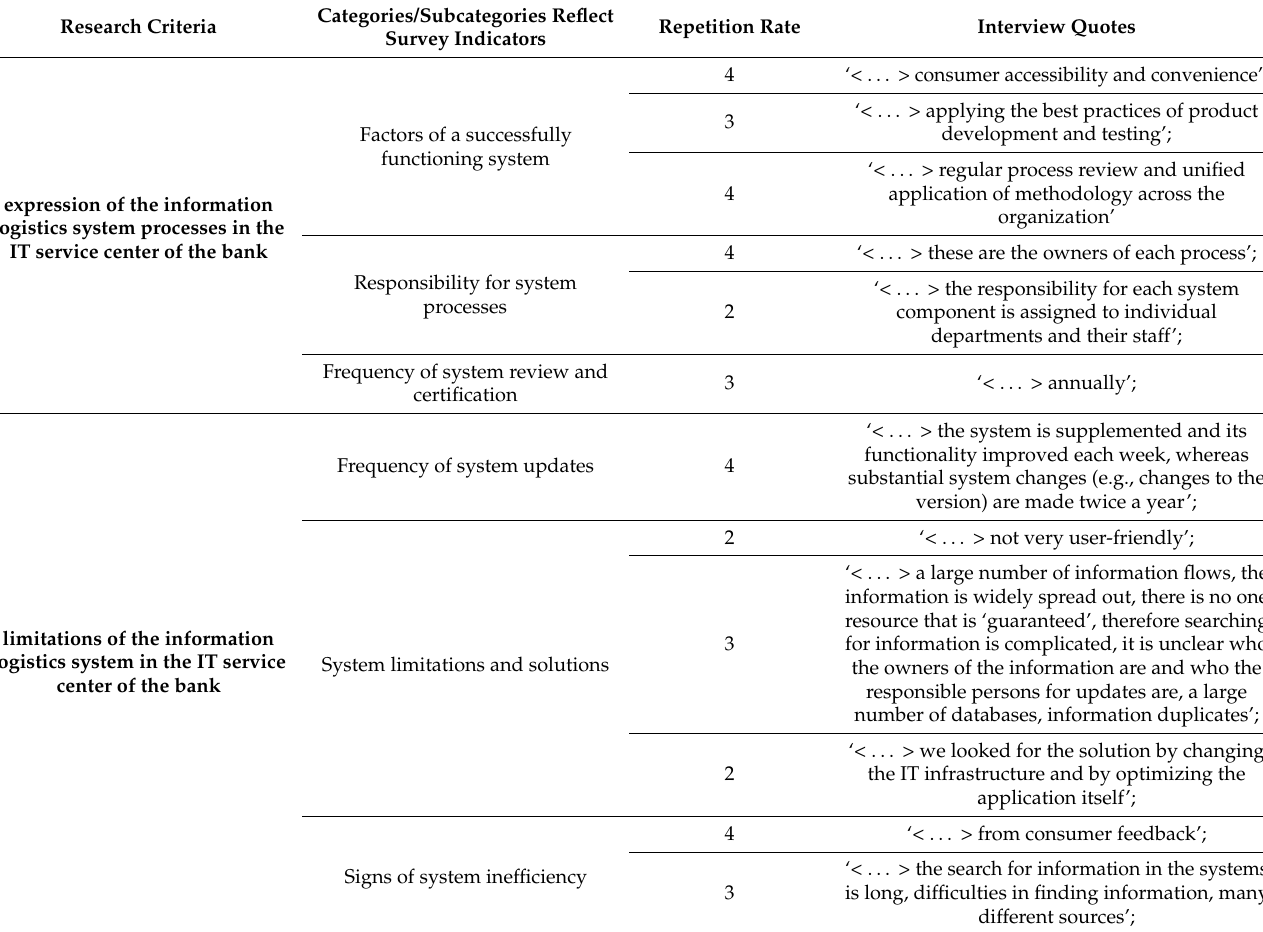
Table 1. Triangulation Findings of the Semi-structured Interview Content